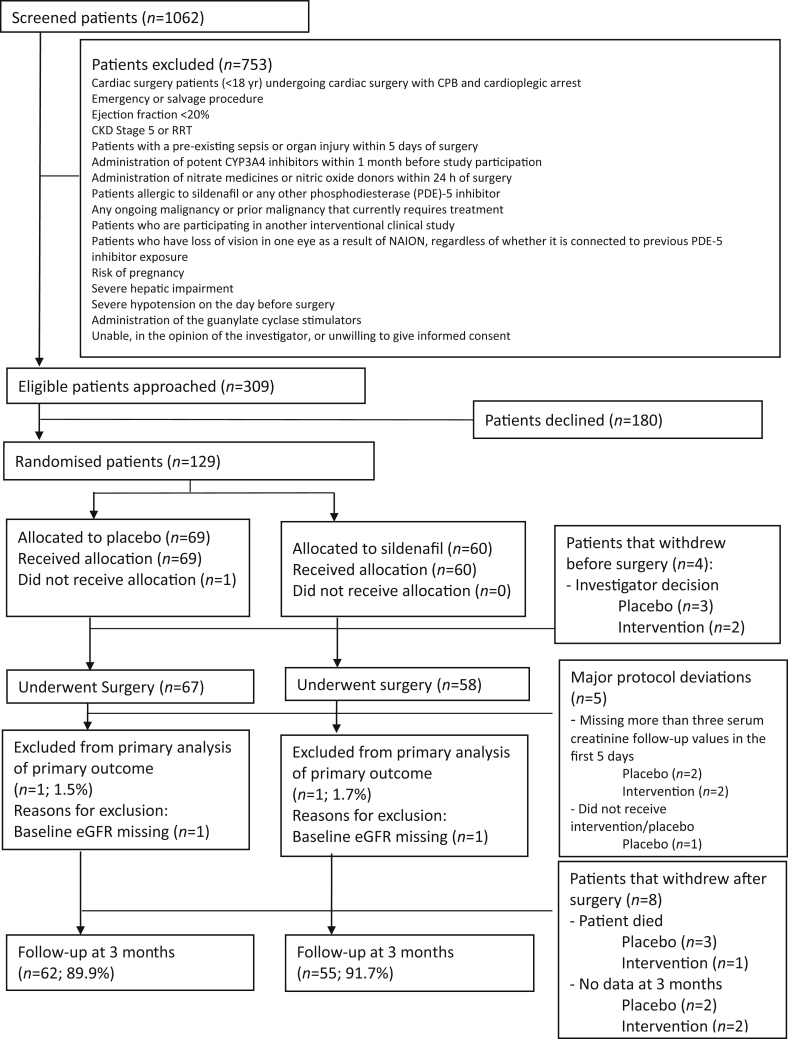
Flow of participants showing eligibility, recruitment, protocol deviations, withdrawals, and loss to follow-up in the REVAKI-2 trial. CKD, chronic kidney disease; CYP3A4, cytochrome P450 3A4; eGFR, estimated glomerular filtration rate; NAION, non-arteritic anterior ischaemic optic neuropathy; RRT, renal replacement therapy.